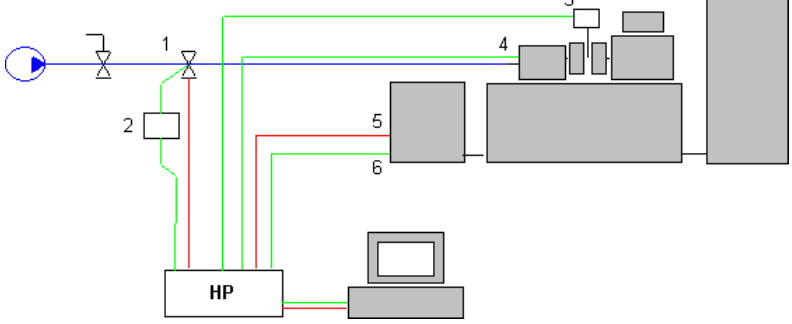
Figure 1. A control and measurement schematic of UMT-2168 friction testing machine [36]: 1— pneumatic valve, 2—4/20 mA armature, 3—thermocouple, 4—moment of friction converter, 5—0– 1500 rpm generator control, 6—tachometric